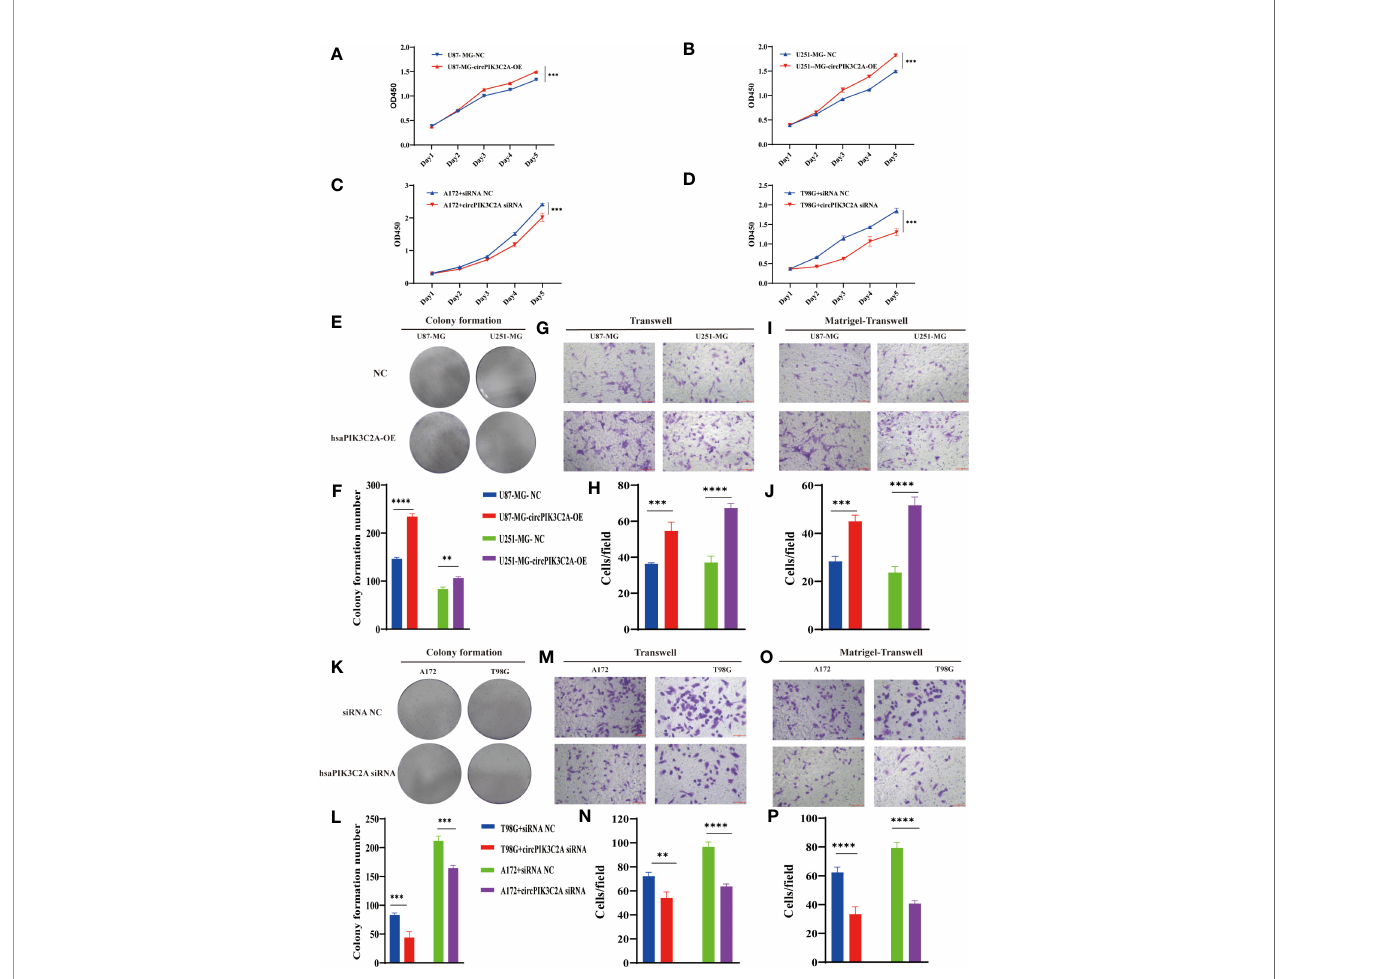
FIGURE 2 | CircPIK3C2A affects GBM cell proliferation, colony formation, invasion, and migration. (A – D) CCK-8 assays were performed using U87-MG (A) and U251-MG (B) with or without circPIK3C2A- OE and using A172 (C) and T98G (D) cells with or without circPIK3C2A-KD. (E – J) Colony formation analyses (E, F) , transwell analyses (G, H) and matrigel-transwell assays (I, J) of U87-MG and U251-MG with or without circPIK3C2A-OE were performed. Representative staining images are presented (magni fi cation: 200×; scale bar = 100 m m). (K – P) Colony formation analyses (K, L) , transwell analyses (M, N) and matrigel-transwel analyses (O, P) of A172 and T98G with or without circPIK3C2A-KD were performed. Representative staining images are presented (magni fi cation: 200×; scale bar = 100 m m). Data are presented as the mean ± SEM of 3 independent experiments. Signi fi cant results are presented as **P < 0.01, ***P < 0.001, and ****P <